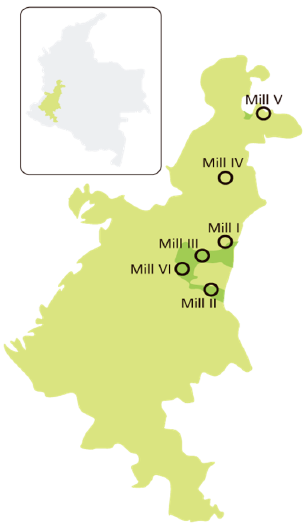
Figure 9. Geographical distribution of annexed distilleries in the valley of the Cauca River.